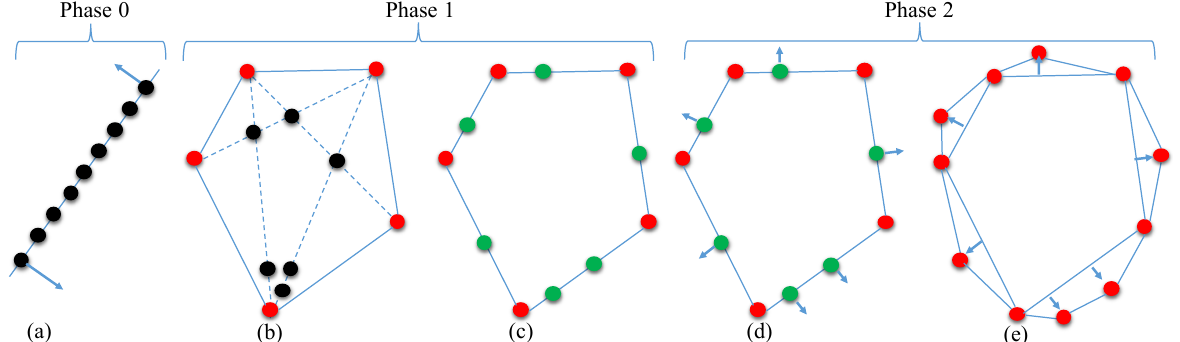
Figure 7. The three stages (or phases) of the algorithm: ( a ) shows an initial linear configuration in Stage 0; ( b ) shows either the initial non-linear configuration or when the initial linear configuration in ( a ) is transformed to a non-linear configuration; ( c ) shows the configuration of robots at the end of Stage 1, in which all the robots are on the perimeter of a convex polygon; ( d ) shows how the sides robots of the convex polygon moving towards the exterior of the polygon in Stage 2 to become corners of a polygon; and finally ( e ) shows the final configuration in Stage 2 in which all robots are on the corners of a convex polygon solving C OMPLETE V ISIBILITY